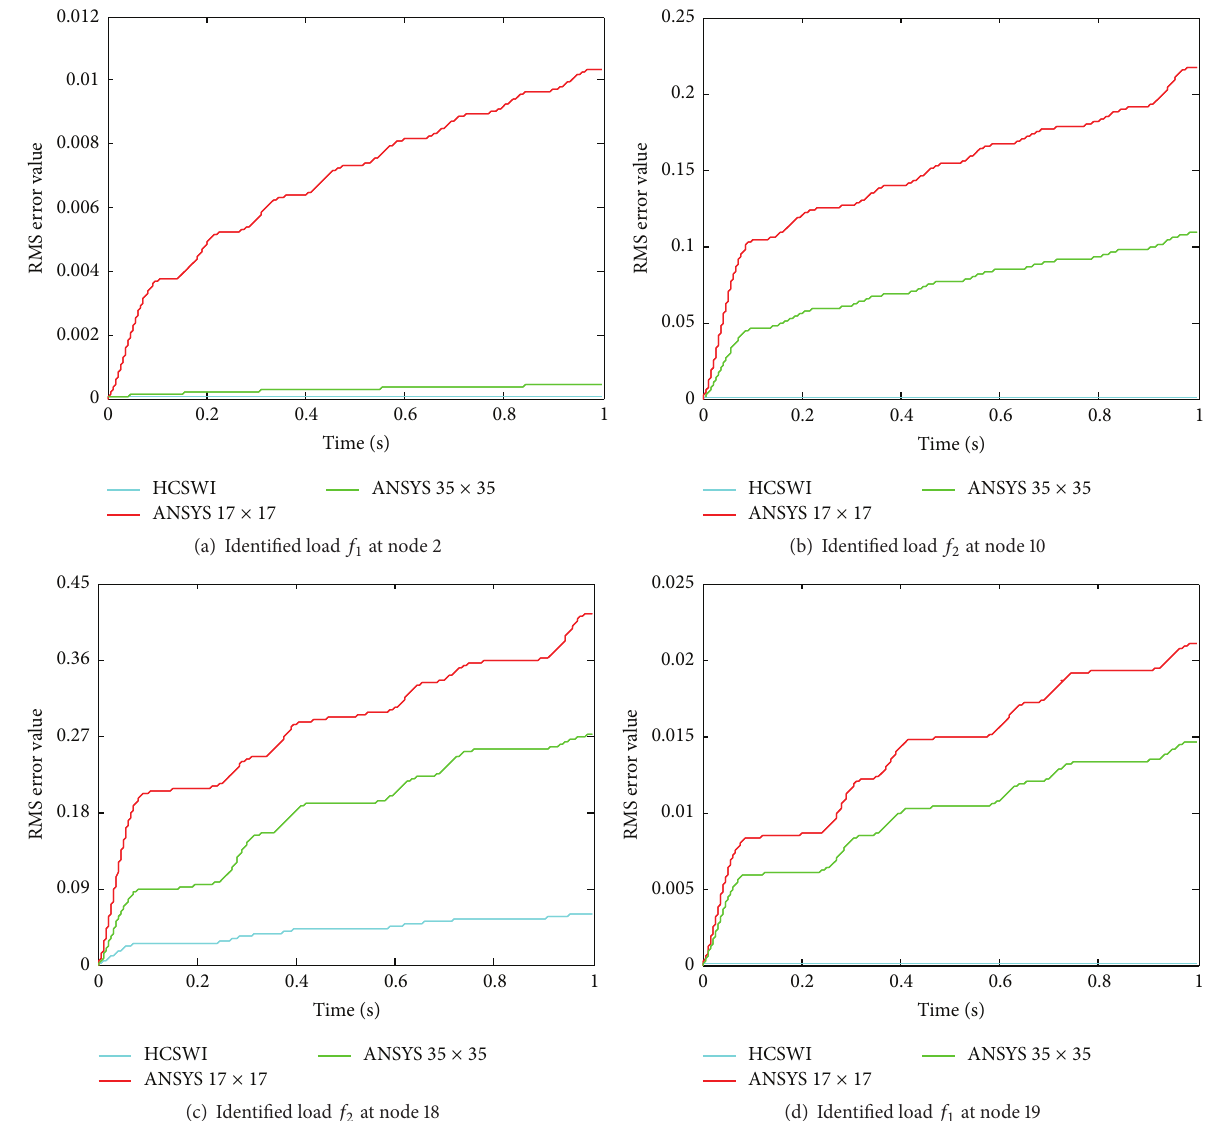
Figure 19: The root mean square error value with excitation 𝑓 1 and excitation 𝑓 2 applied at nodes 1 and 18.